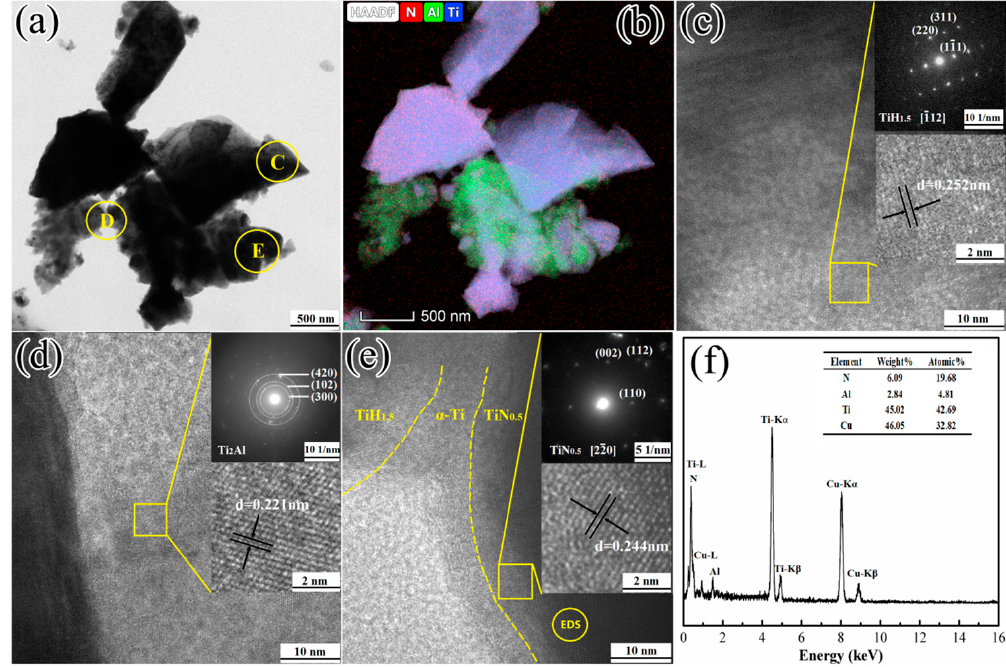
Figure 10. ( a ) TEM image; ( b ) elemental mapping of N, Al, and Ti; ( c – e ) HRTEM images and electron diffraction patterns; and ( f ) EDS analysis of the 1TiH 2 /1.15Al/1TiN powder system after one minute of sintering at 620 °C.